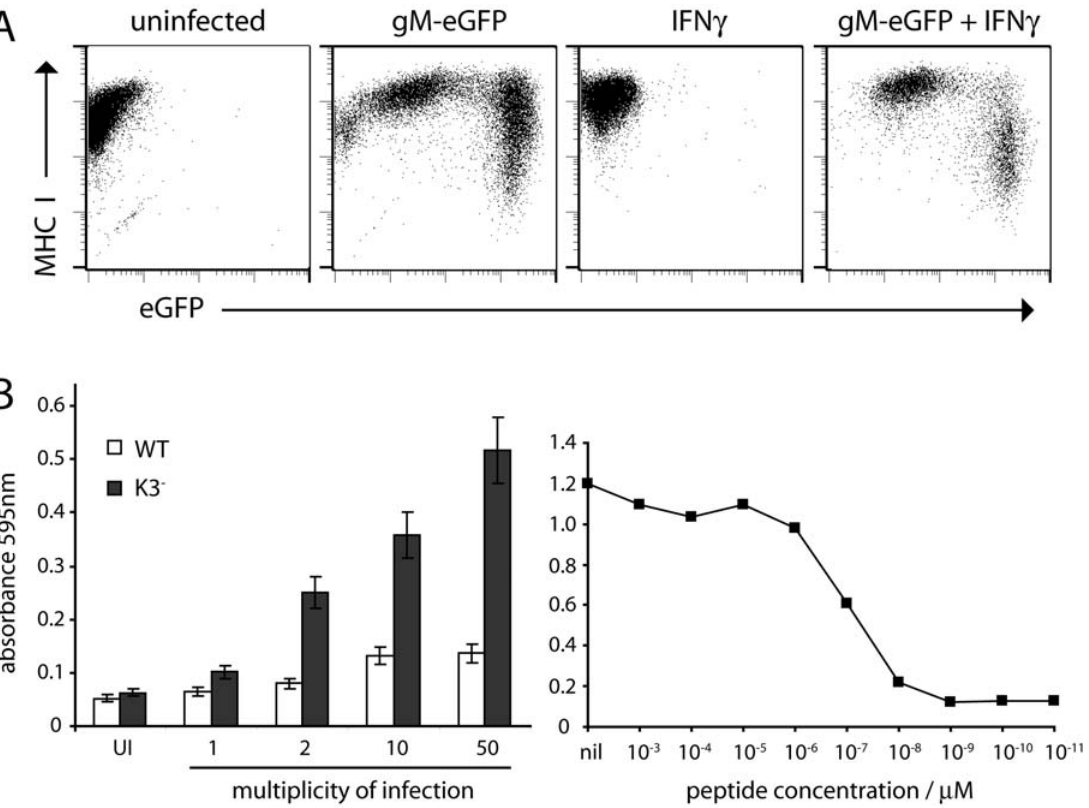
Figure 8. MHV-68 inhibits MHC class I-restricted antigen presentation in macrophages. A. RAW264.7 cells were infected overnight with gM-eGFP MHV-68 (2PFU/cell), treated or not with IFN c (20 U/ml) for a further 24 h, then stained for cell surface MHC class I. The data are from 1 of 2 equivalent experiments. B. Peritoneal macrophages from C57BL/6 mice were left uninfected (UI), infected overnight with wild-type (WT) or K3-deficient (K3 2 ) MHV-68 at different multiplicities, or incubated with dilutions of the immunodominant H2-D b -restricted MHV-68 peptide p56, to relate